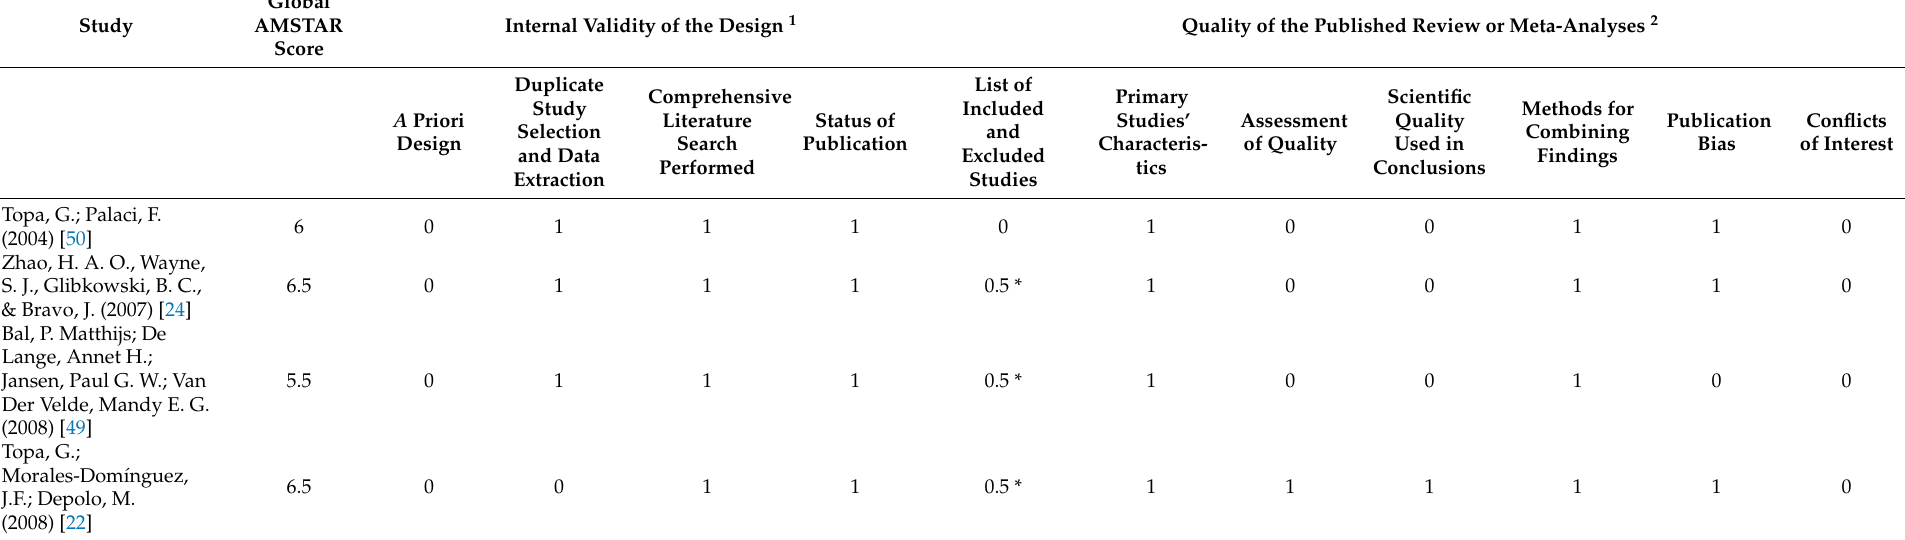
Table 4. Quality assessment of the included reviews and meta-analyses using